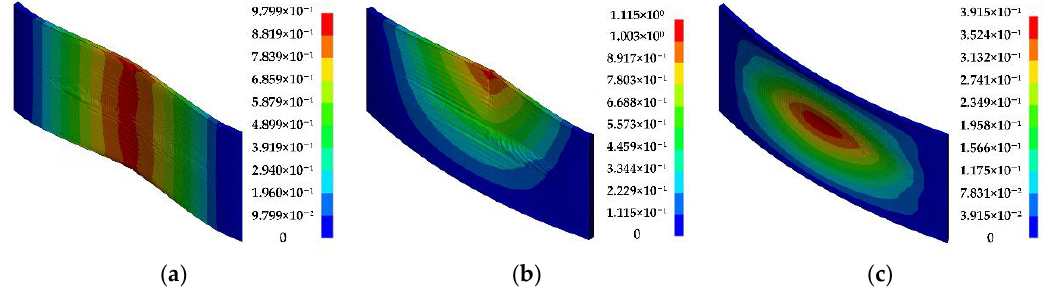
Figure 31. Deformation of blast wall with different boundary conditions. ( a ) Two sides fixed; ( b ) Three sides fixed; and ( c ) Four sides